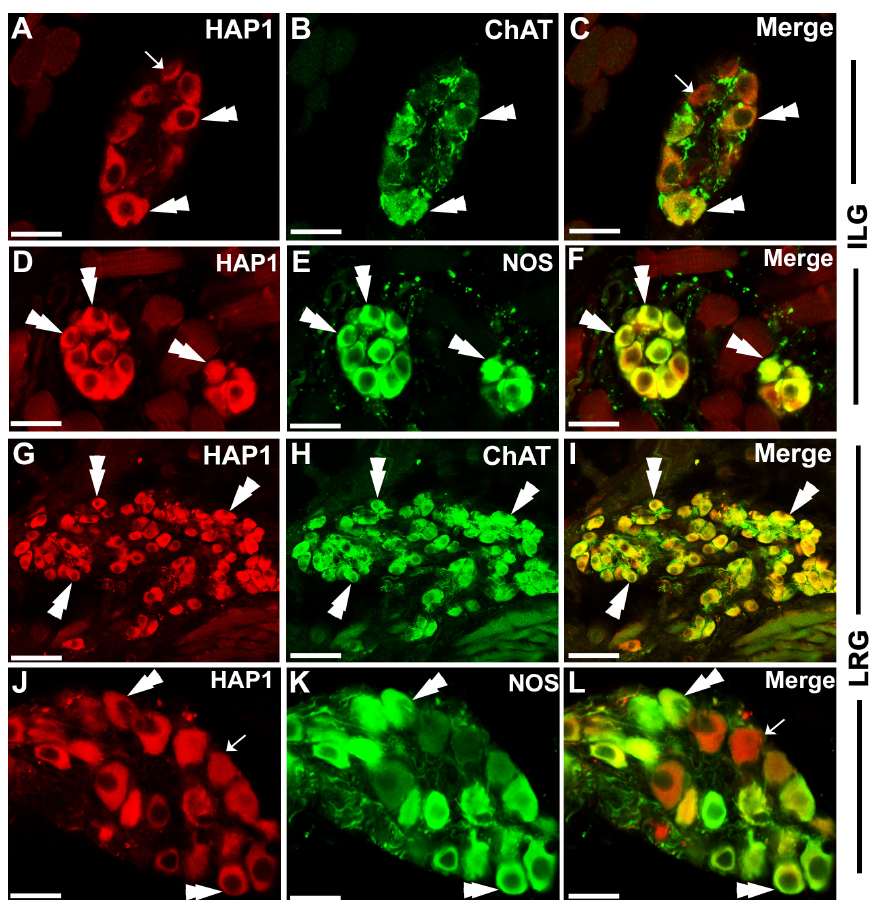
Figure 2. Double immunofluorescence staining for HAP1 with ChAT or NOS. Photomicrograph showing the coexpression of HAP1 with ChAT in ILG ( A – C ) or LRG ( G – I ); and HAP1 with NOS in ILG ( D – F ) or LRG ( J – L ). Cells positive for both HAP1 and NOS or ChAT are indicated by double arrowheads. Cells single-positive for HAP1 are indicated by arrows. ILG, intralingual ganglion; LRG, lingual root ganglion. Scale bar = 25 µm in ( A – F , J – L ), and 50 µm in ( G – I ).